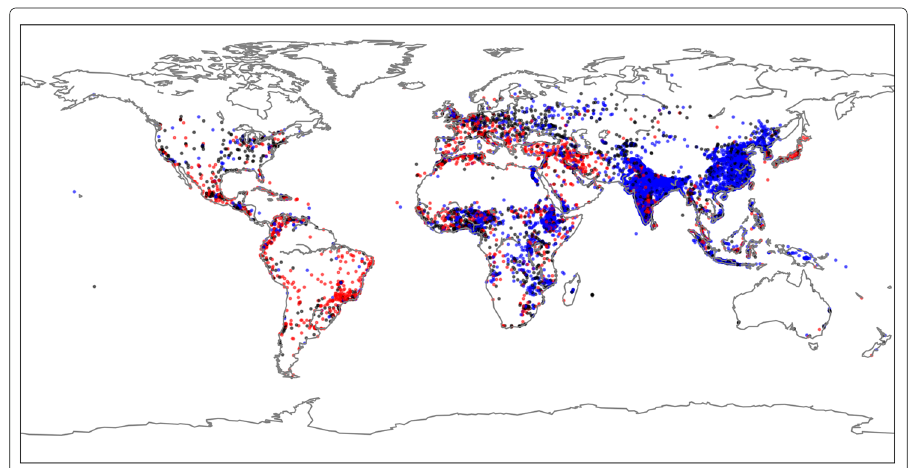
Fig. 7 Distribution of urban street forms across the globe. Each dot represents a city and is colour-coded according to cluster memberships in Figure 6a. Despite limited data size, spatial trends start to emerge, such as the concentration of high-density urban networks in California, USA (red cluster) and low-density urban networks in south-eastern Asia (black